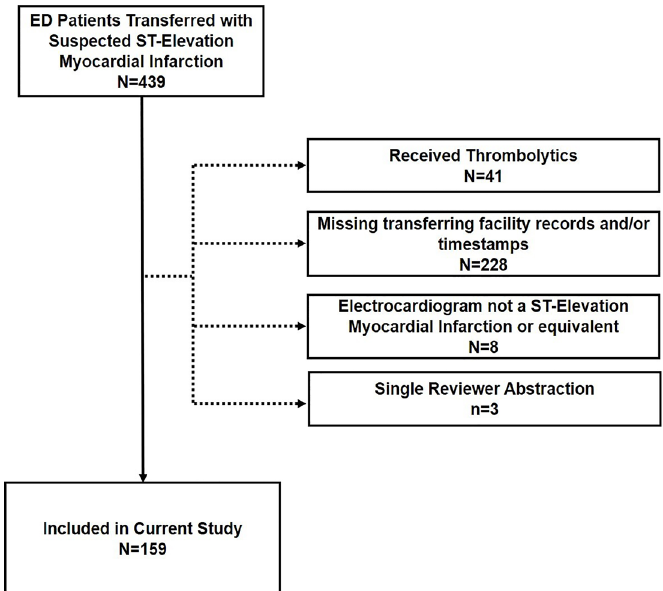
Figure 1. CONSORT Diagram for study population.